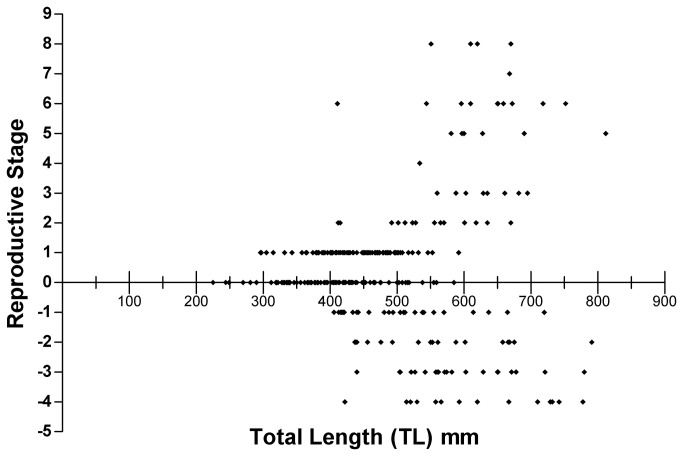
A scatterplot of reproductive stage vs total length.Note that all animals above 585 mm TL were readily identifiable as either male or female.